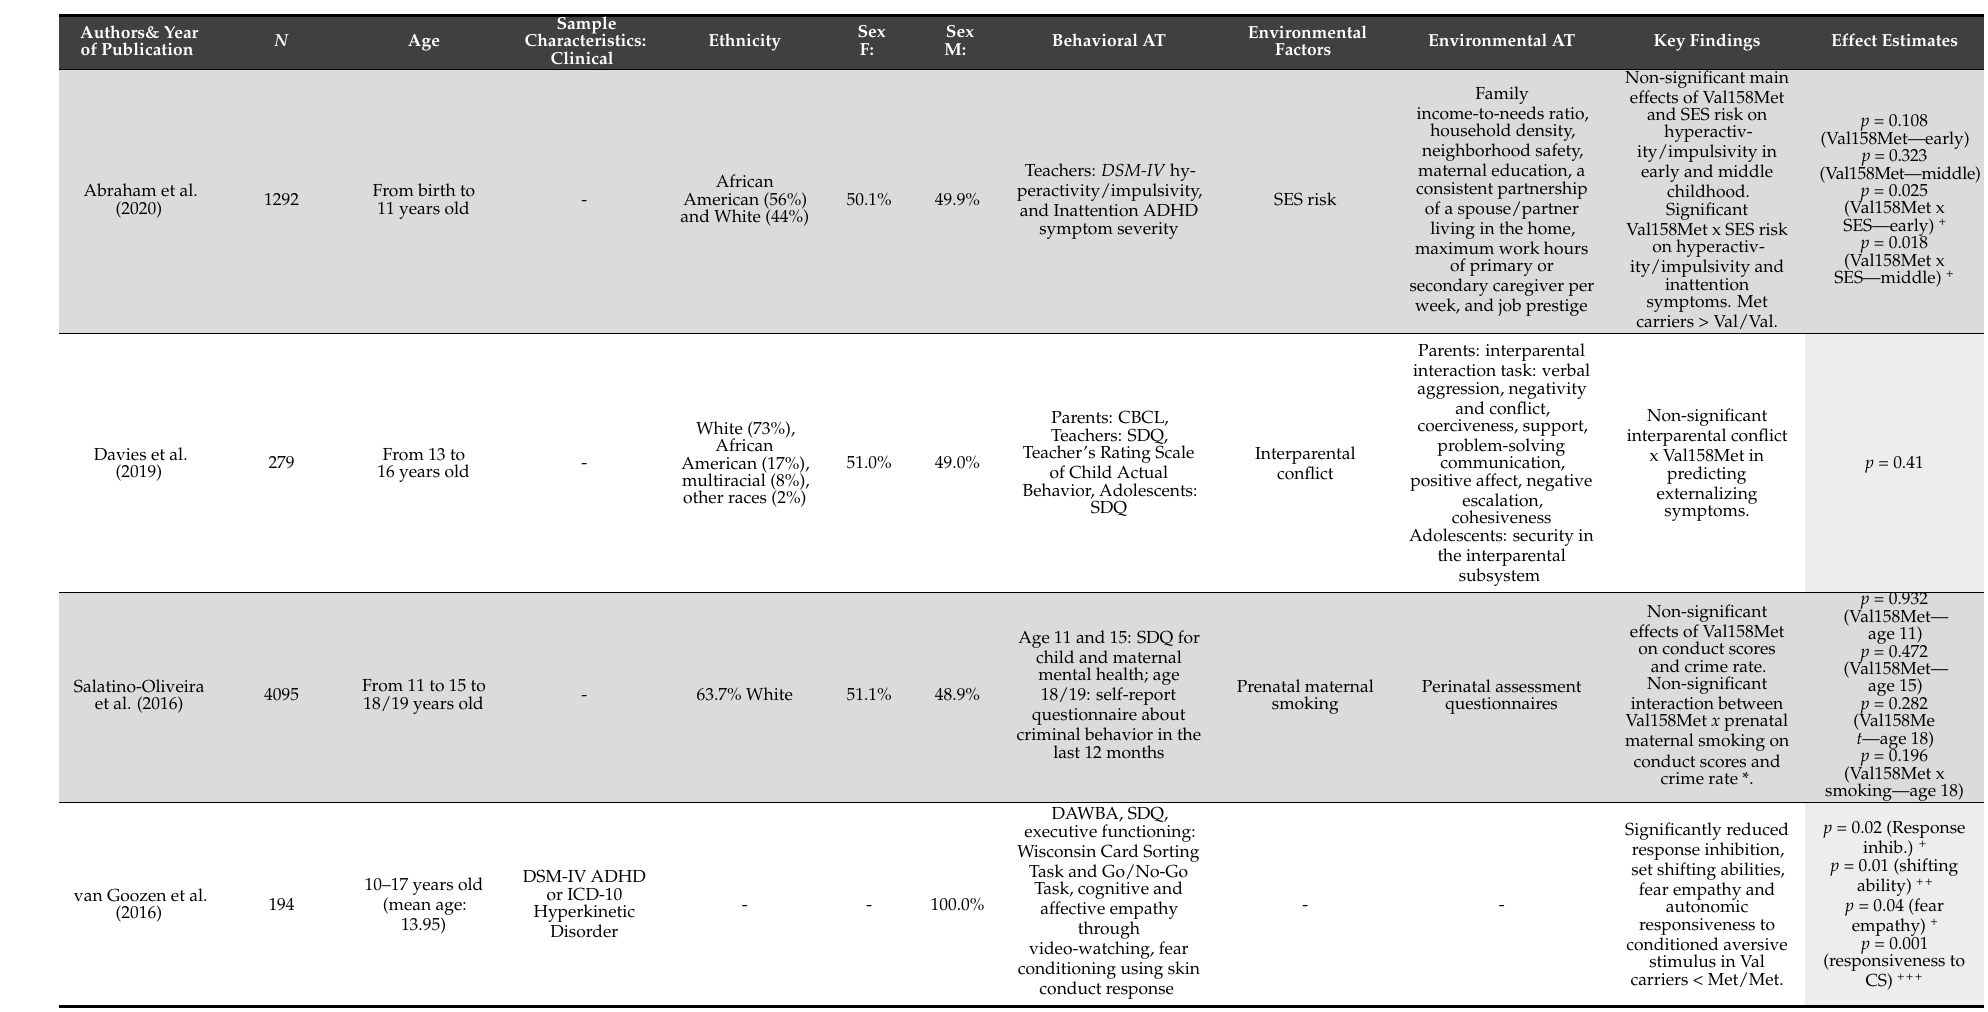
Table 1. The extracted data items from the studies analyzed in the systematic